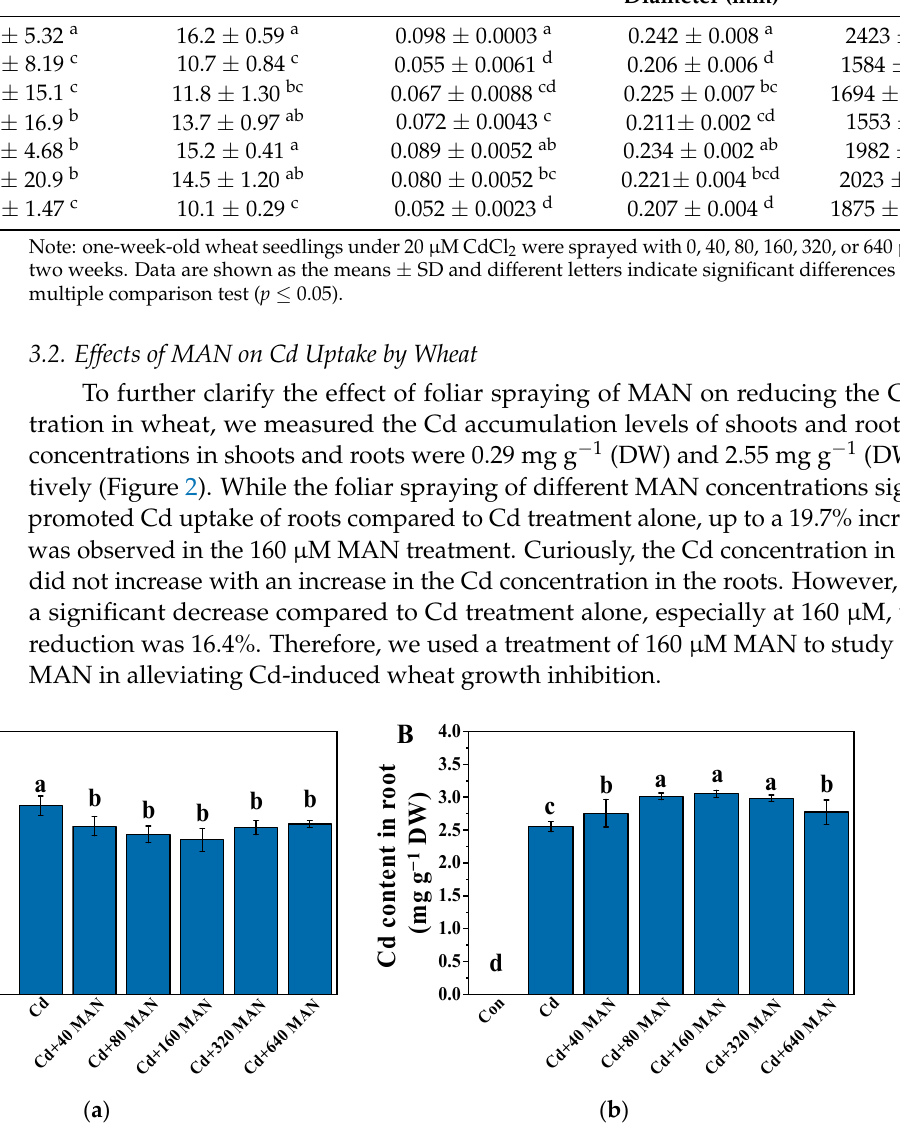
Figure 2. Effects of different concentrations of MAN on Cd accumulation in shoots ( A ) and roots ( B ) of wheat seedlings under Cd stress. One-week-old wheat seedlings under 20 µ M CdCl 2 were sprayed with 0, 40, 80, 160, 320, or 640 µ M MAN for two weeks. Data are the means ± SD and different letters above columns indicate a significant difference at p ≤ 0.05 among treatments.